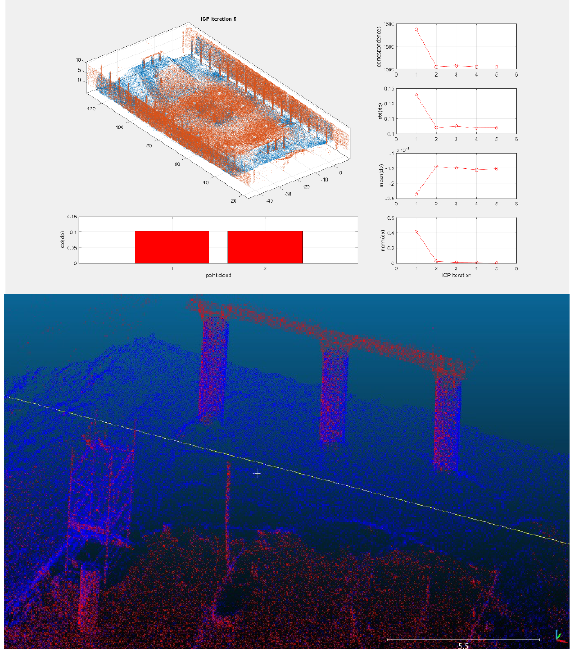
Figure 13 . Pairwise scan alignment with Point Cloud Tools for Matlab software. Upper image: Windows command line user interface shows a good agreement after alignment operations between red (TLS-derived) and blue (SLAM-derived) point clouds. Lower image: detail of the aligned point clouds in CloudCompare.